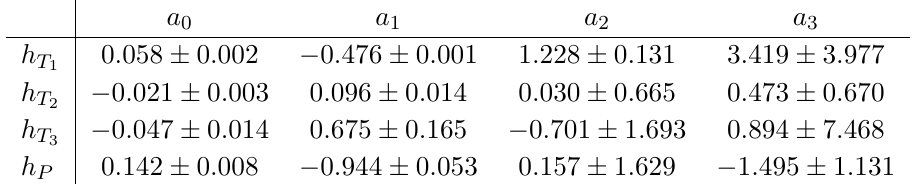
Table 2 . Parameters a n in eq. (C.2).